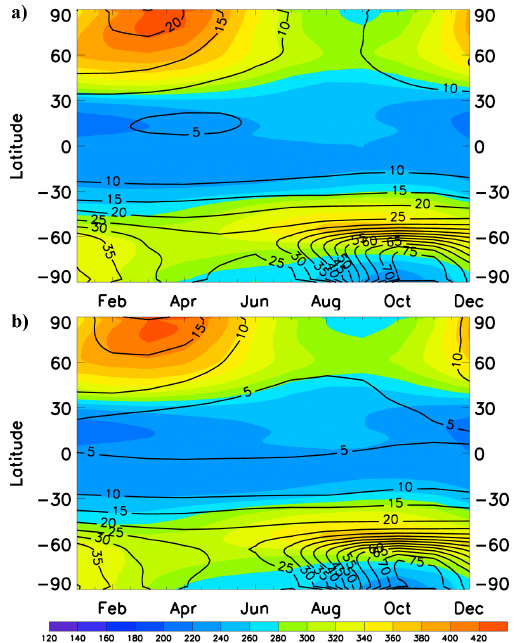
Figure 2. Zonal mean stratospheric column O 3 changes in units of DU (shown by color) and 2 Fig. 2. Zonal mean stratospheric column O 3 changes in units of DU the relative change in % (shown by contours) in the H 2 -FC scenarios compared with the BL 3 (shown by color) and the relative change in % (shown by contours) scenarios as a function of latitude and time of a year for (a) A1FI and (b) B1 scenarios. 4 in the H 2 -FC scenarios compared with the BL scenarios as a func- tion of latitude and time of a year for (a) A1FI and (b) B1